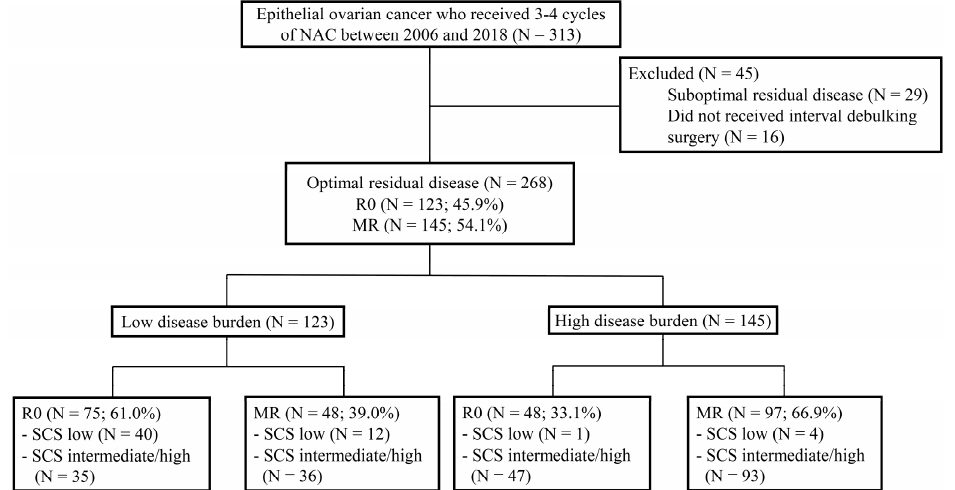
Figure 1. Flow diagram of the study population. NAC, neoadjuvant chemotherapy; R0, no residual disease; MR, <1 cm of residual disease; SCS, surgical complexity score.